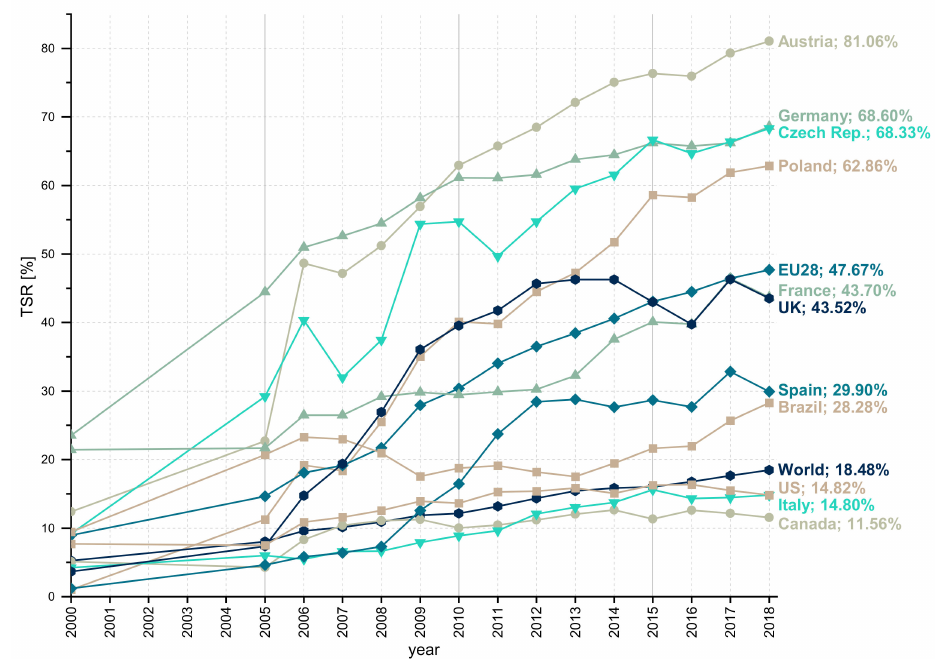
Figure 14. Development of the thermal substitution rate (in %) of SRF in the cement industry in different countries, the EU, and worldwide for the time period 1990–2018